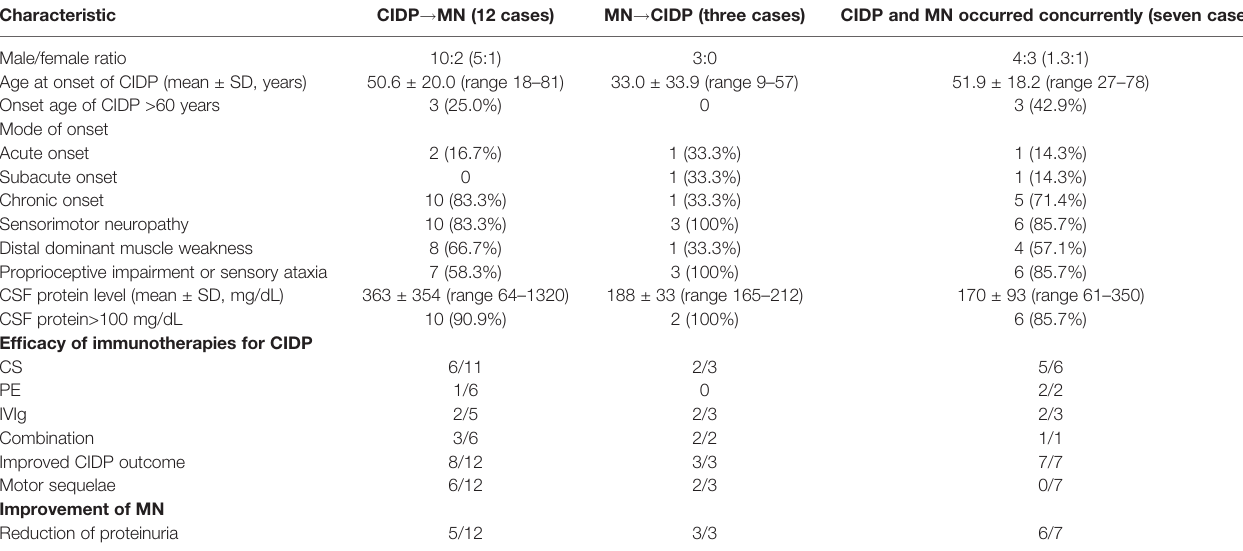
TABLE 4 | Comparison of the clinical characteristics of chronic in fl ammatory demyelinating polyneuropathy (CIDP) with membranous nephropathy (MN) with different chronological orders of onset.